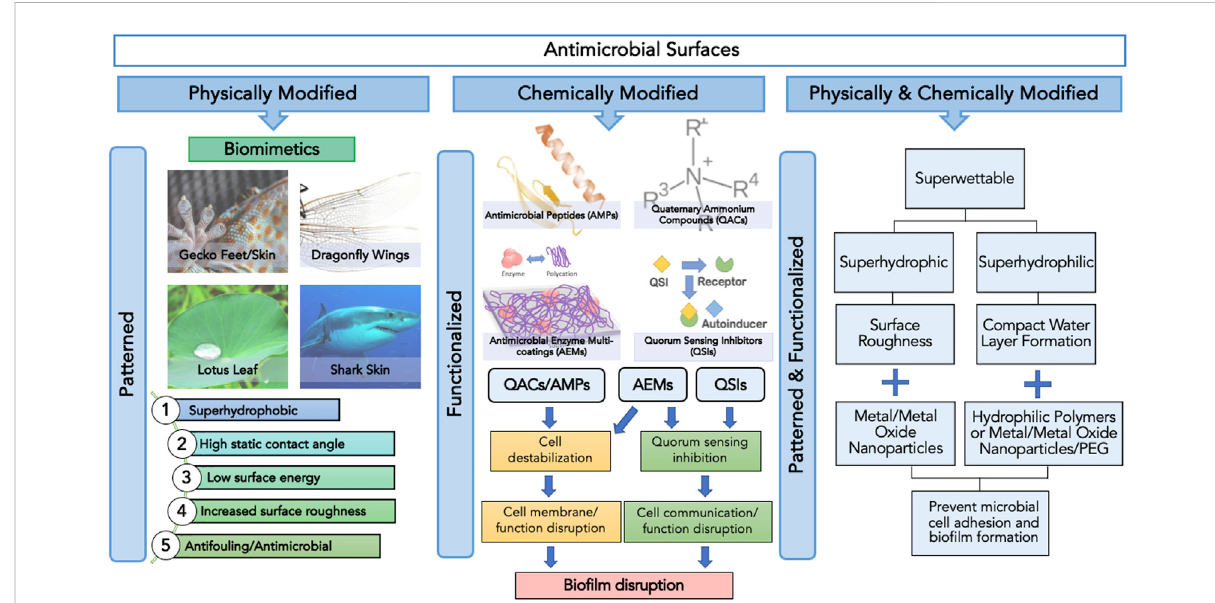
FIGURE1 Categories of antimicrobial surfaces based on the method of surface modi fi cation, namely physical, chemical and physicochemical, and their respective surface features and functions.